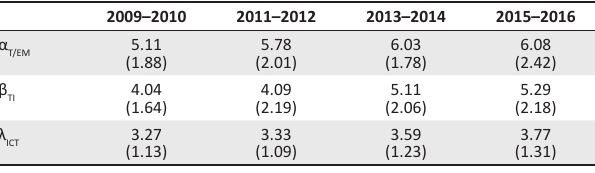
FIGURE 4: Summary of panel data estimations: Technology–employee ratio and technology